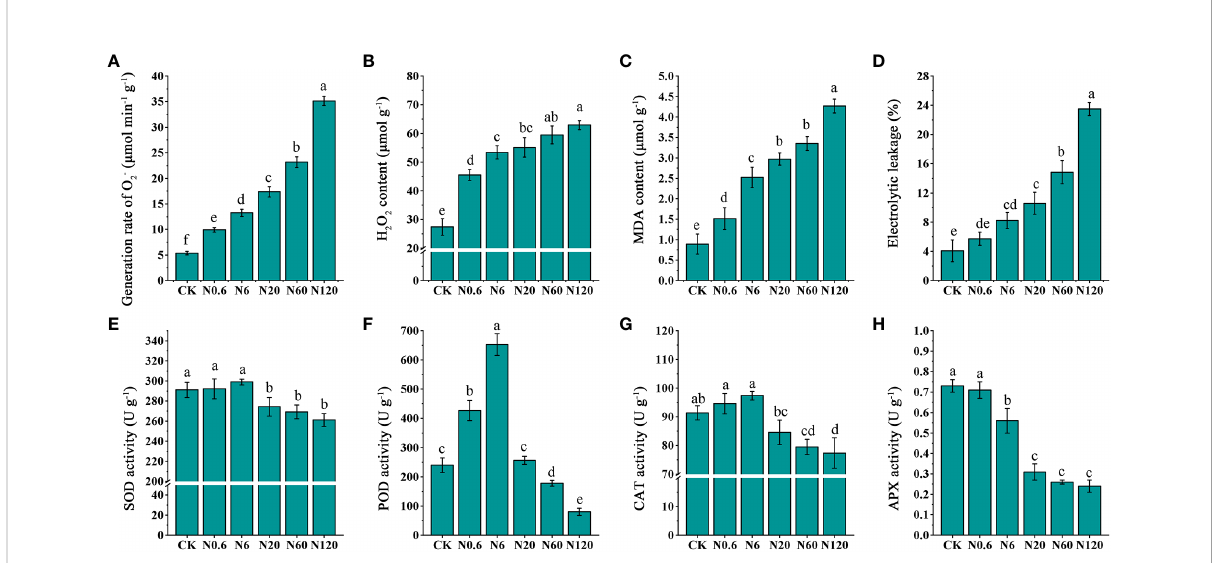
FIGURE 7 Effects of nicosulfuron the on physiological indicators of sugar beet leaf. The generation rate of O − 2 (A) , H 2 O 2 content (B) , malondialdehyde (MDA) content (C) , electrolytic leakage (EL) (D) , SOD activity (E) , POD activity (F) , CAT activity (G) , and APX activity (H) in sugar beet on 20 DAT with different doses of nicosulfuron. Data with the different letters indicate signi fi cant differences between different doses of nicosulfuron drift (n = 6, p <